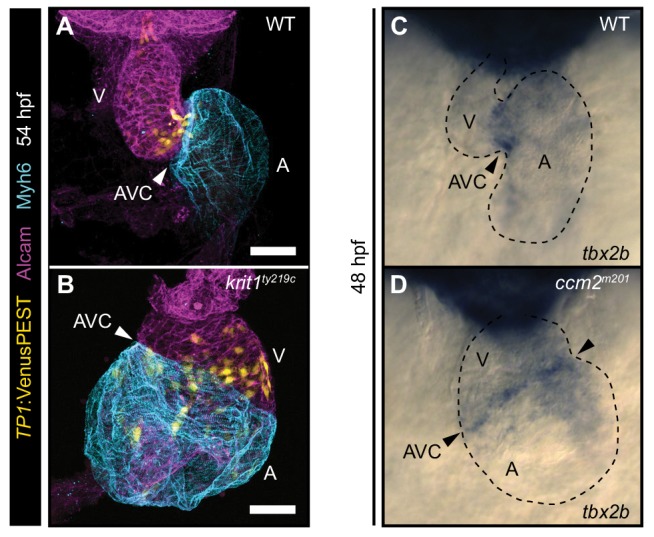
The region of Notch activity within the endocardium is expanded in krit1ty219c mutants.(A, B) Projections of confocal z-stack images of embryonic hearts marked by Tg(TP1:VenusPEST)s940 expression (yellow), Myh6 staining (cyan), and Actin staining (magenta) at 54 hpf. (A) In wild-type (WT), Notch activity is highest in endocardial cells of the atrioventricular canal (AVC) and outflow regions. (B) In krit1ty219c mutants, the domain of high Notch activity is expanded to ventricular and atrial endocardial cells. (C, D) Whole-mount in situ hybridization of tbx2 cardiac expression at 48 hpf. (A) Tbx2 expression is restricted to the atrioventricular canal (AVC) both in wild-type (WT) and in ccm2m201 mutants (B). Arrowheads point at the AVC. A: atrium, V: ventricle, Scale bars are 50 μm (A, B).